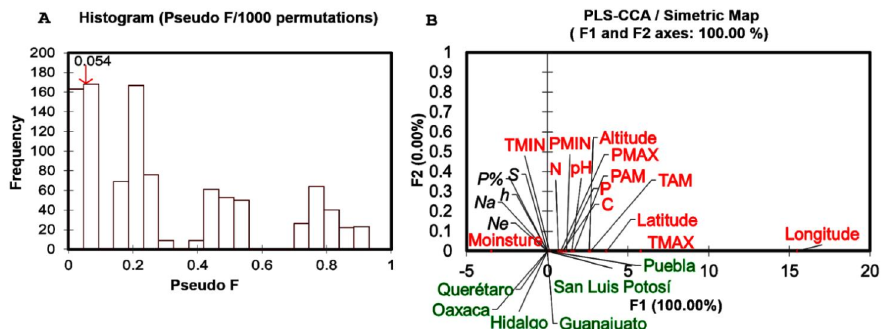
Figure 10. Partial least squares canonical correspondence analysis (PLS-CCA) of genetic diversity and environmental variables. ( A ) Histogram of permutation test. ( B ) Symmetric map of CCA among sites, genetic diversity and